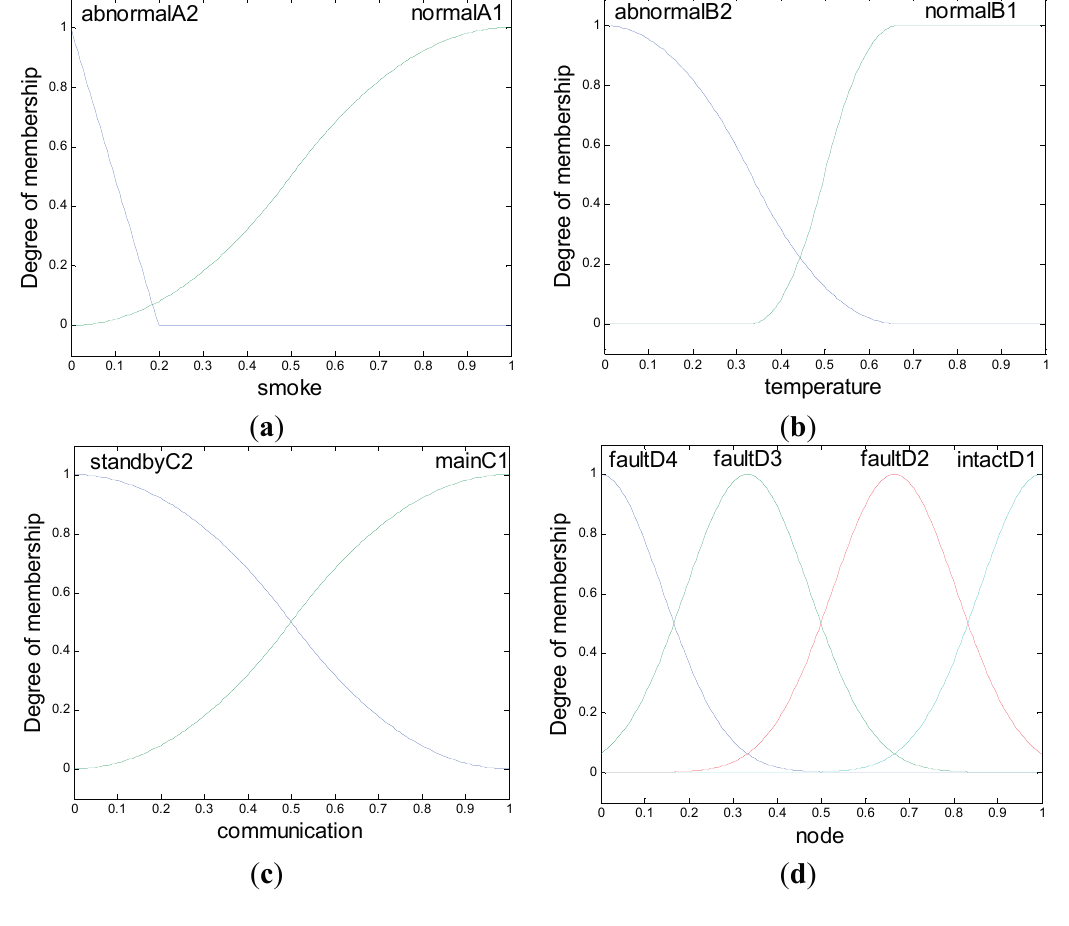
Figure 3. Membership functions. ( a ) smoke; ( b ) temperature; ( c ) communication; ( d )